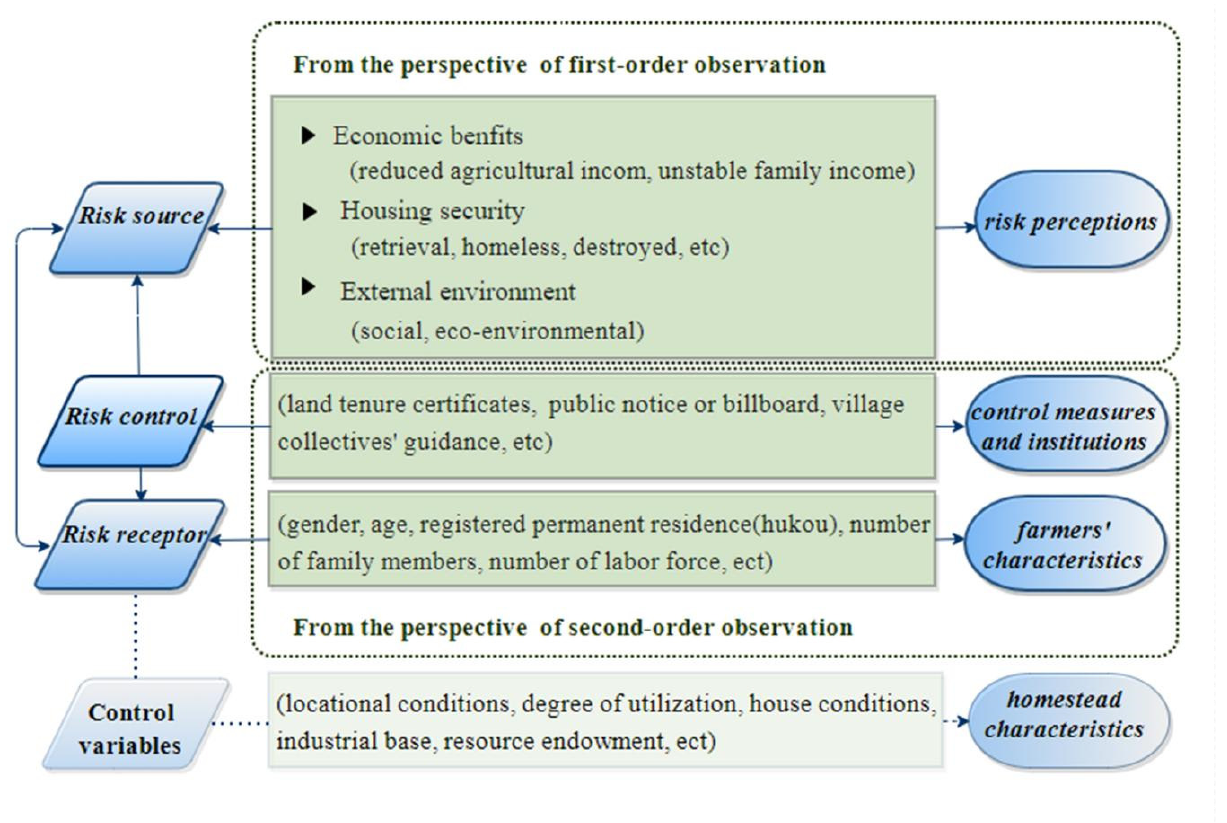
Figure 1. Theoretical analysis